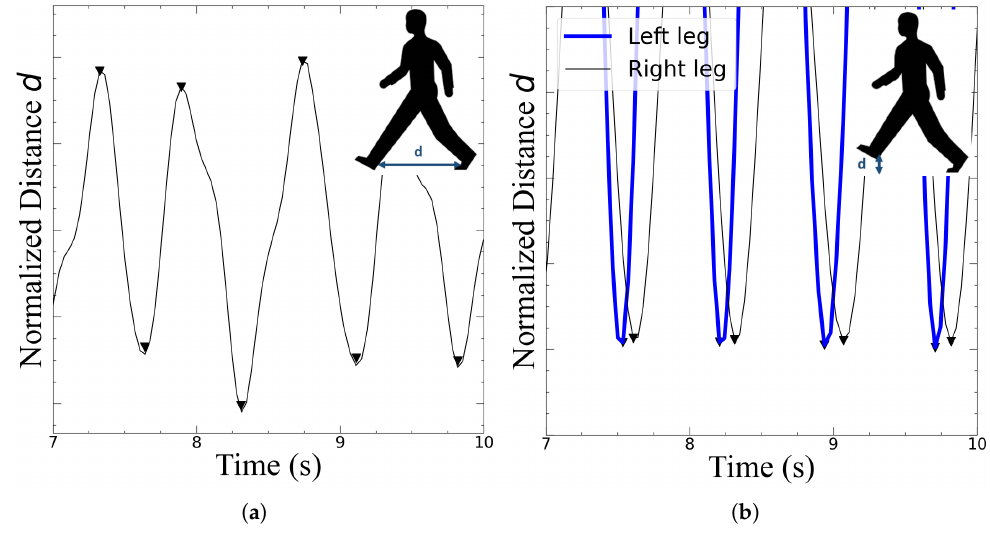
Figure 4. ( a ) Type I and ( b ) Type II data segmentation types. Table 1. Data segmentation types for feature